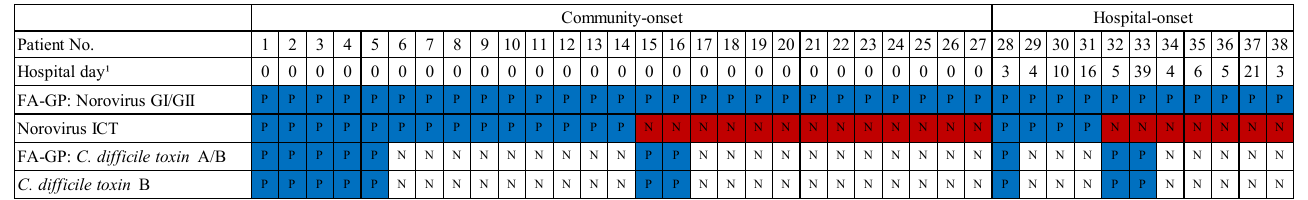
Figure 4. Detection of Norovirus and C. difficile toxin by FA-GP versus Norovirus ICT and C. difficile toxin B PCR in patients with community-onset and hospital-onset diarrhea. Compared to the FA-GP, norovirus ICT was only able to detect 14/27 (51.8%) patients with norovirus genes present in the stools of patients with community-onset diarrhea, and 4/11 (36.4%) in the stools of patients with hospital-onset diarrhea. However, the detection positivity was the same for FA-GP and AllplexTM GI-Bacteria(I) assay for C. difficile toxin. The P in shaded regions represent positive results, the N in white shaded regions represent negative results, and N in the red shaded regions represent negative result possibly leading to lack of infection prevention control measures. 1 Onset of diarrhea according to hospital day. FA-GP, FilmArray-gastrointestinal panel; ICT, immunochromatography test.